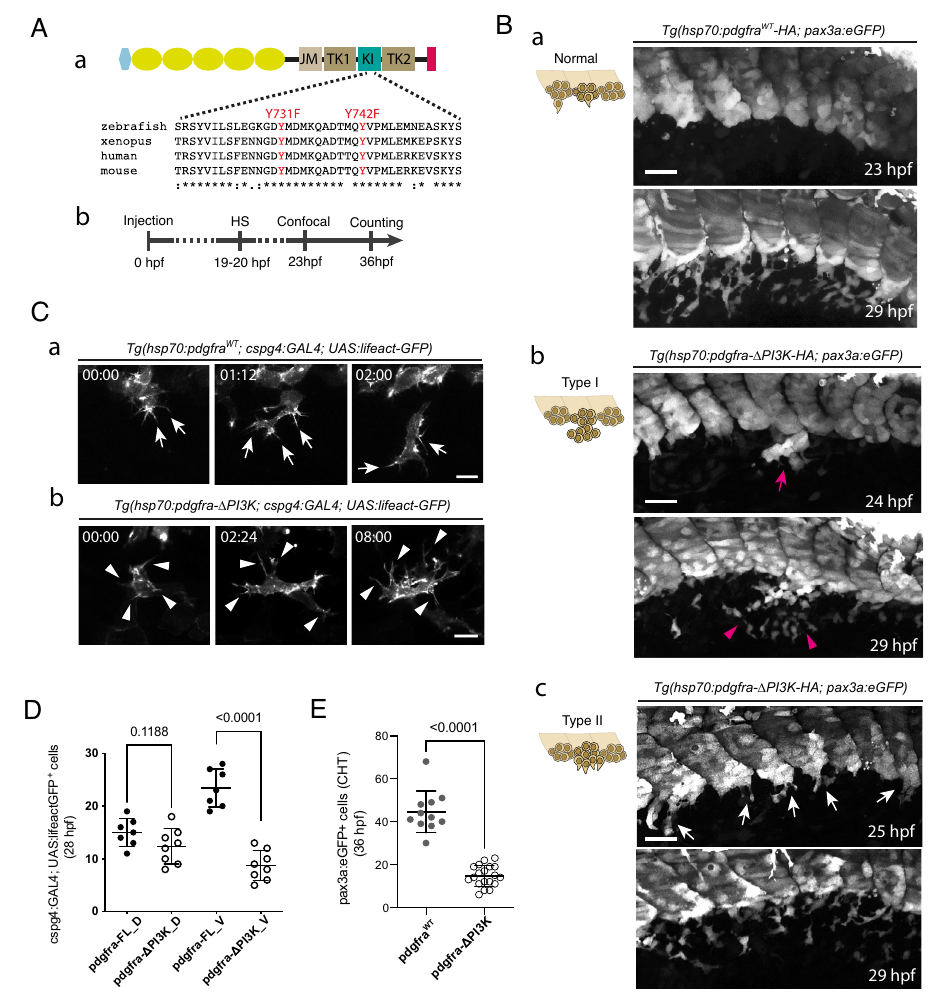
Fig. 4 | Pdgfr- α in fl uences cluster cohesion and SCP migration behavior through PI3K binding. A ( a ) Schematic representation of Pdgfrafused to tandem HA-tag (red) at its C-terminus, and amino acid alignment around the site of mutationsintheKI(kinaseinsert)domain.Thelightbluehexagonandyellowovals indicate the signal peptide and Ig-like extracellular domains, respectively; JM jux- tamembrane,TK1tyrosinekinasedomain1,TK2tyrosinekinasedomain2,tyrosine residues involved in PI3K binding when phosphorylated that we mutated into phenylalaninesareshowninred. b Timecourse of theexperiment;HS,heat-shock. B Confocal projections at 23 and 29 hpf of live Tg(pax3a:eGFP) embryos injected with hsp70:pdgfra WT -HA ( a ) or hsp70:pdgfra- Δ PI3K construct ( b , c ) and heat- shockedat19-20hpf; Tg(hsp70:pdgfra- Δ PI3K;pax3a:eGFP) embryosshowdefectsin VC cohesion (type I, b ) or SCP emergence and migration (type II, c ) (see also Supplementary Fig. 4B). Arrow in b indicates SCPs over fl ow out of the cluster before migration initiation. This cell population was dispersed locally after 5 hrs (arrowheads). c , Arrows indicate multiple SCPs emerging simultaneously from